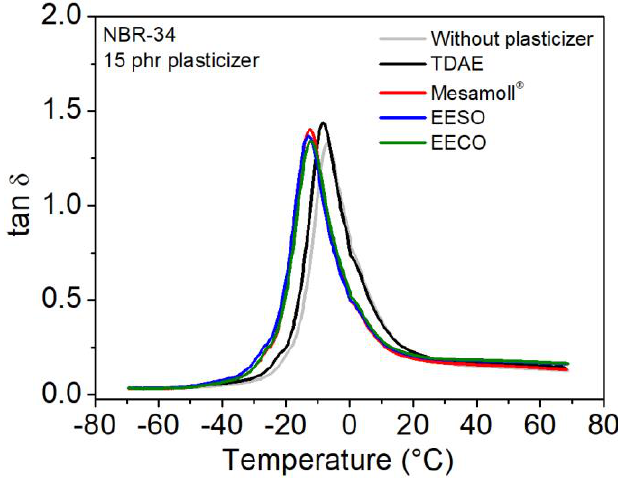
Figure 11. Mechanical loss factor tan δ of NBR-34 vulcanizates with 15 phr various plasticizers as a function of temperature.